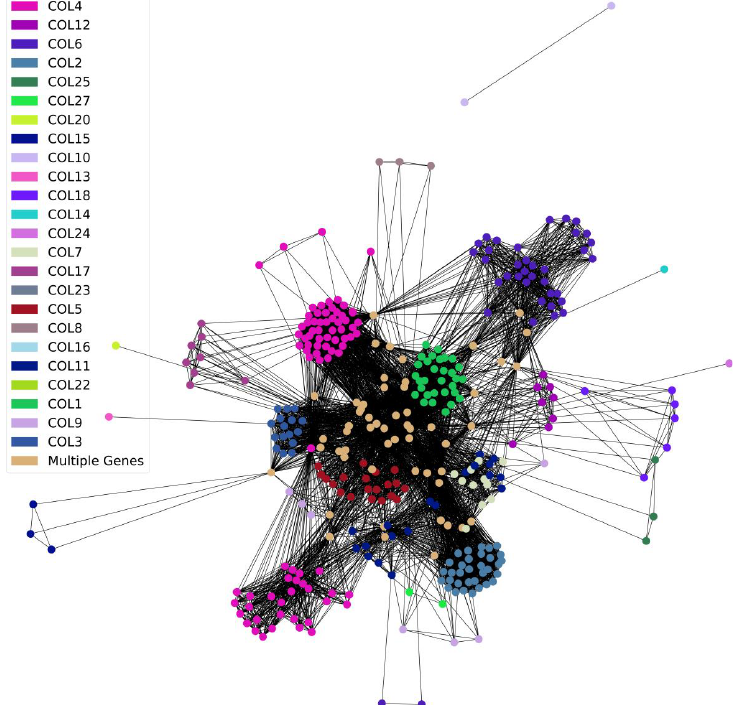
Figure 7. Disease – Collagen – Gene Associations. Numerous disease states are associated with various mutations in different collagen genes. Groups of diseases within the collagen diseasome formed a network in this cluster analysis due to their relatedness to a mutation in specific collagens. Multi- ple diseases, shown in beige, share numerous mutations in different types of collagen genes, which surround the beige centroid (Supplementary Table S9). For further details, including a graphic rep- resentation with the labeling of diseases and a tabular view, please see Supplementary Table S9. Next, we established which amino acid in collagens is the most frequently mutated and associated with diseases. Glycine was by far the most heavily disease-associated mu- tation, followed by proline and arginine (Figure 8A, Supplementary Table S9). For steric reasons, glycine is the smallest amino acid and is required to be in the third position of the (Gly-X-Y) repeats, where X is often proline, and Y is often hydroxyproline [21]. Proline in the endoplasmic reticulum is post-translationally modified to hydroxyproline, which is important for stabilizing the collagen triple helix [21]. Interestingly, the most frequent sub- stitution of an initial glycine is by arginine, followed by aspartic acid, serine, and valine (Figure 8B, Supplementary Table S9).